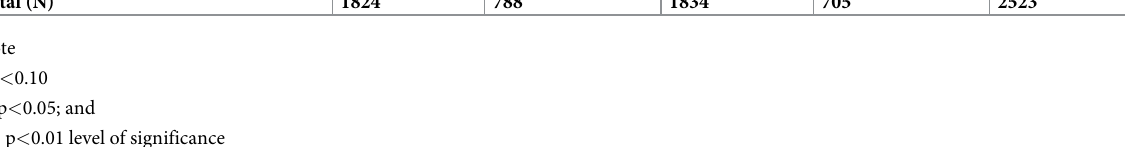
Food secure household Moderately food insecure household Severely food insecure